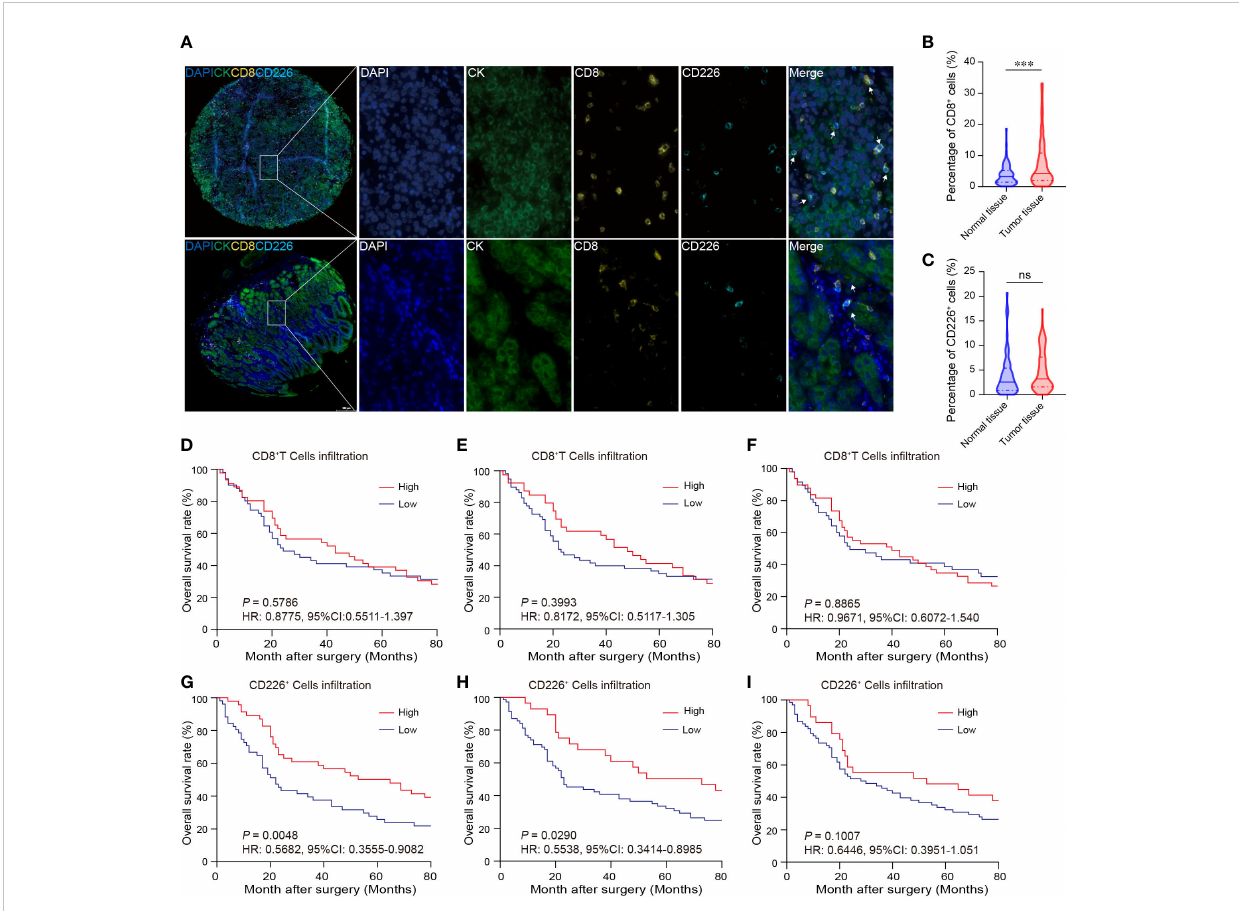
FIGURE 2 The expressions of CD8 and CD226 in human GC TMA. (A) . mIHC and single-color images were obtained from human GC TMA. (B, C) . The populations of CD8 + TILs and CD226 + TILs were compared between normal tissue and GC tissues. (D, G) . Prognostic values of CD8 + TILs and CD226 + TILs in GC. (E, H) . Prognostic values of CD8 + TILs and CD226 + TILs in GC in the epithelial cell region. (F, I) . Prognostic values of CD8 + TILs and CD226 + TILs in GC in the stromal cell